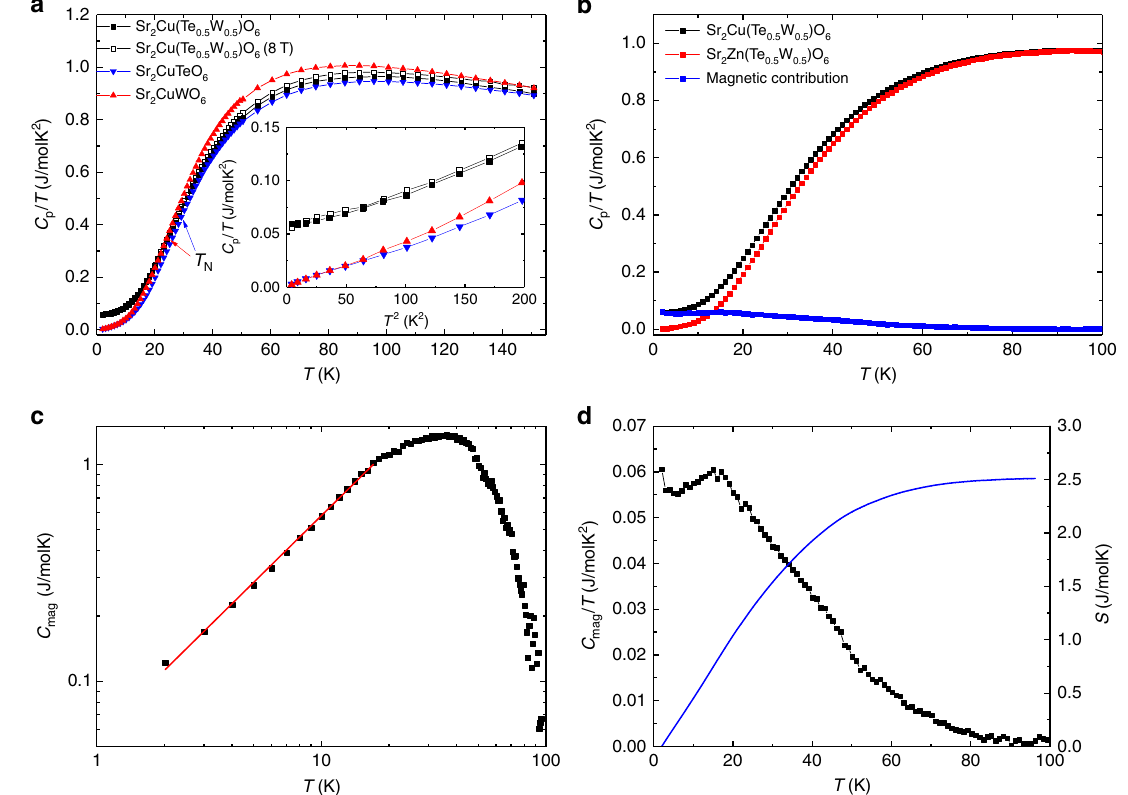
Fig. 3 Speci fi c heat measurements. a Speci fi c heat of Sr 2 Cu(Te 0.5 W 0.5 )O 6 , Sr 2 CuTeO 6 and Sr 2 CuWO 6 . Inset: Low-temperature C p / T vs. T 2 plot. b Speci fi c heat of Sr 2 Cu(Te 0.5 W 0.5 )O 6 , lattice standard Sr 2 Zn(Te 0.5 W 0.5 )O 6 and the subtracted magnetic speci fi c heat of Sr 2 Cu(Te 0.5 W 0.5 )O 6 . c Log – log plot of magnetic speci fi c heat of Sr 2 Cu(Te 0.5 W 0.5 )O 6 . The red line is a fi t to γ T α , which yields α = 1.02(1) con fi rming T -linear behavior. d Magnetic speci fi c heat (black) and integrated entropy (blue) of Sr 2 Cu(Te 0.5 W 0.5 )O